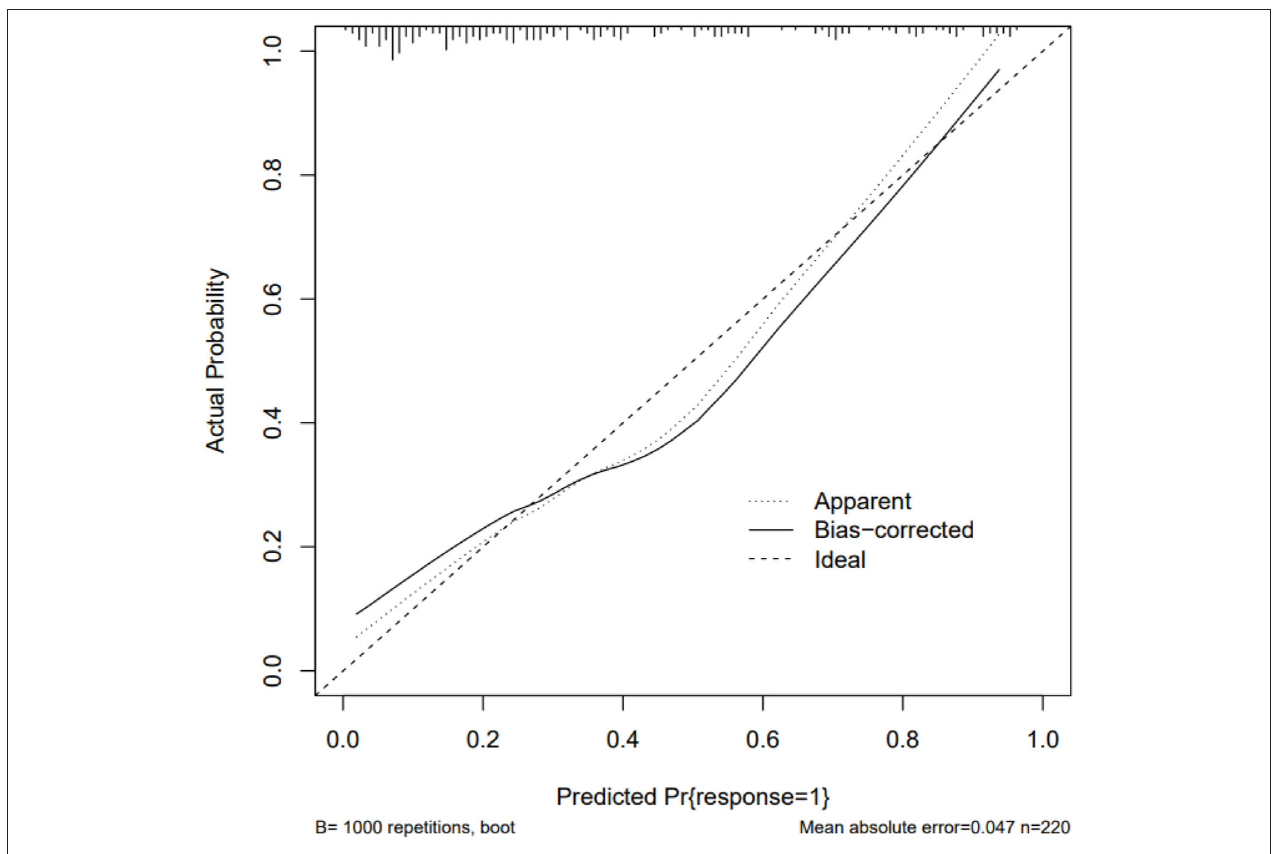
FIGURE 4 | The calibration curve for the model in the training